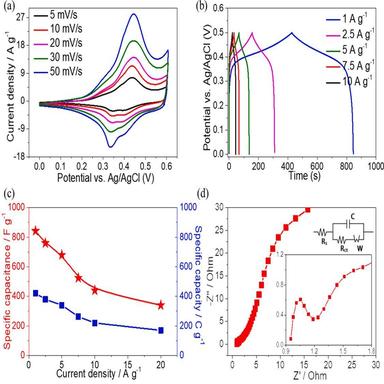
Electrochemical performance of Co-O-NSs@CFC (a) CV curves, (b) GCD curves, (c) specific capacitance versus current density, and (d) Nyquist plot of EIS.